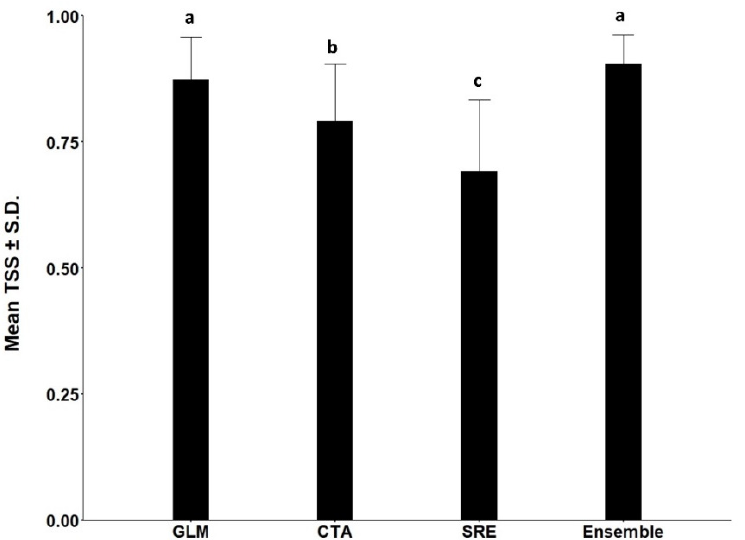
Figure 4. Mean TSS ( ± S.D.) scores of individual ( n = 60) and ensemble models ( n = 49) for predicting E. polonica presences. GLM: generalized linear model, CTA: classification tree analysis, SRE: surface range envelope. Bars with the same letter are not significantly different according to multiple pairwise comparisons ( p < 0.05).